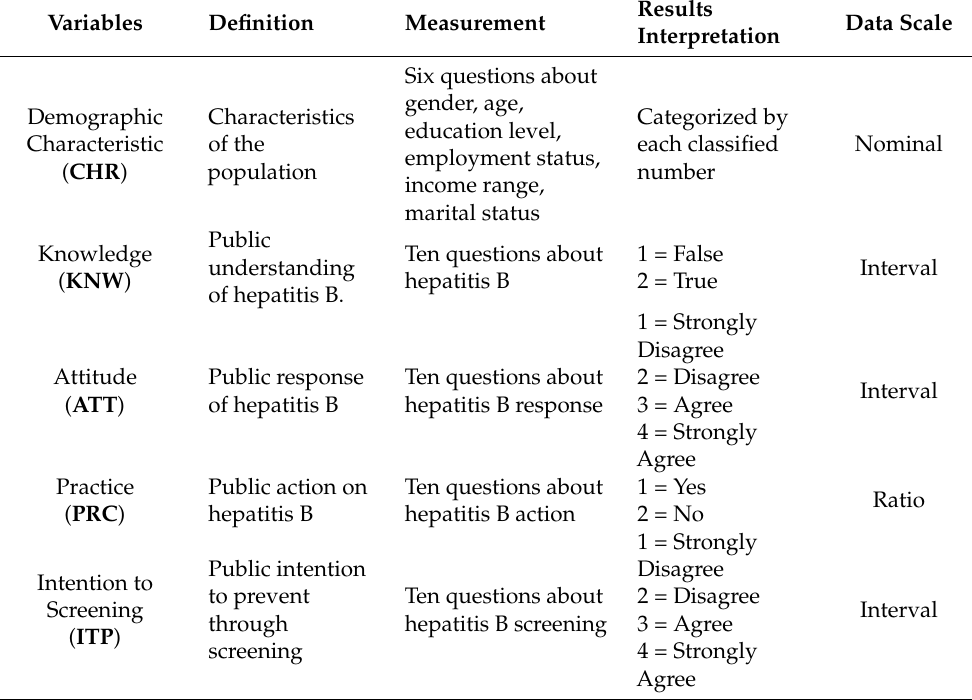
Table 1. Operational Definition of